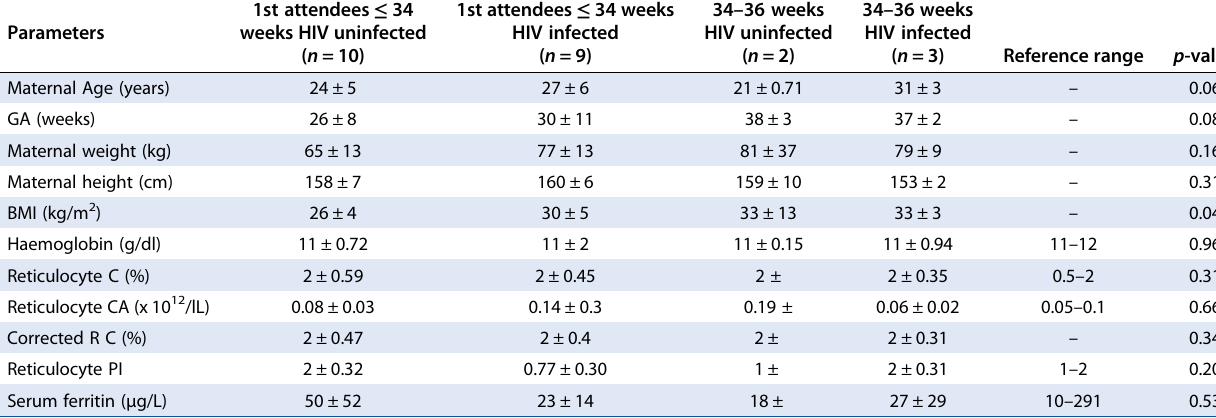
Table 3: Clinical data collected during pregnancy follow-up